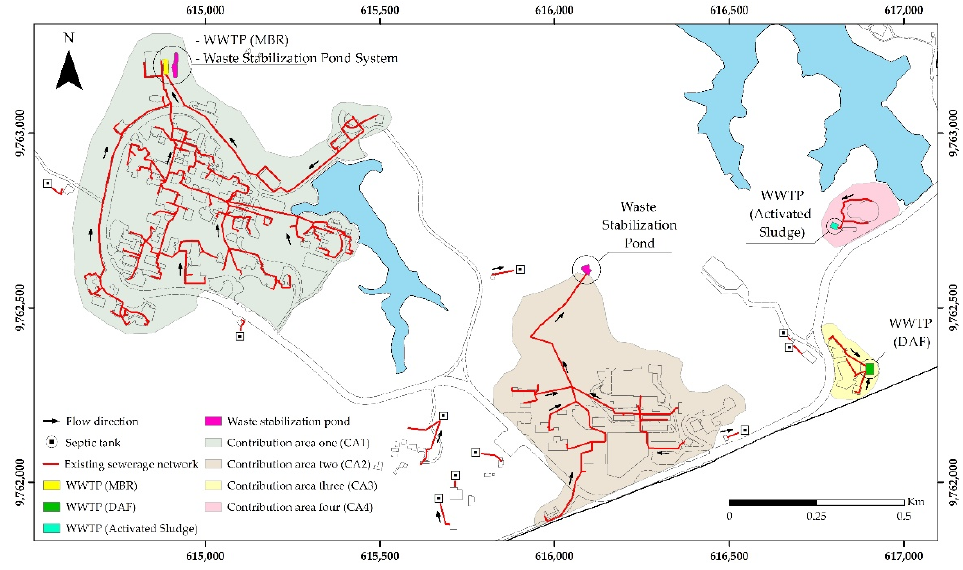
Figure 8. Existing sewerage system and final wastewater disposal.